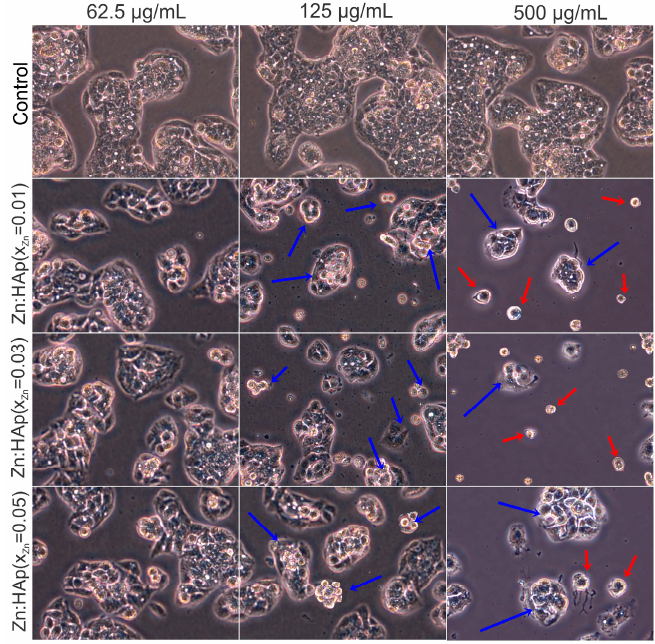
Figure 8. Inverted phase contrast microscopy of HepG2 cells cultivated in the presence of Zn:HAp with x Zn = 0.01, x Zn = 0.03 and x Zn = 0.05 at three different concentrations (62.5, 125 and 500 µg/mL) compared to control.